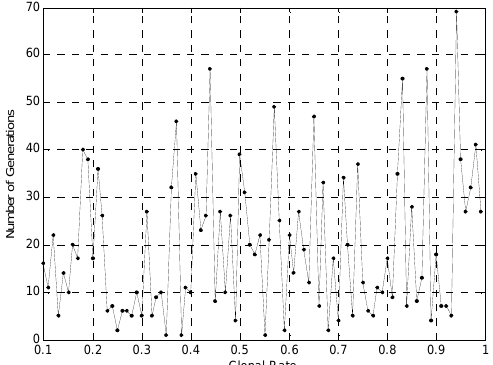
Fig. 14. Sensitivity of Clonal Rate R c .